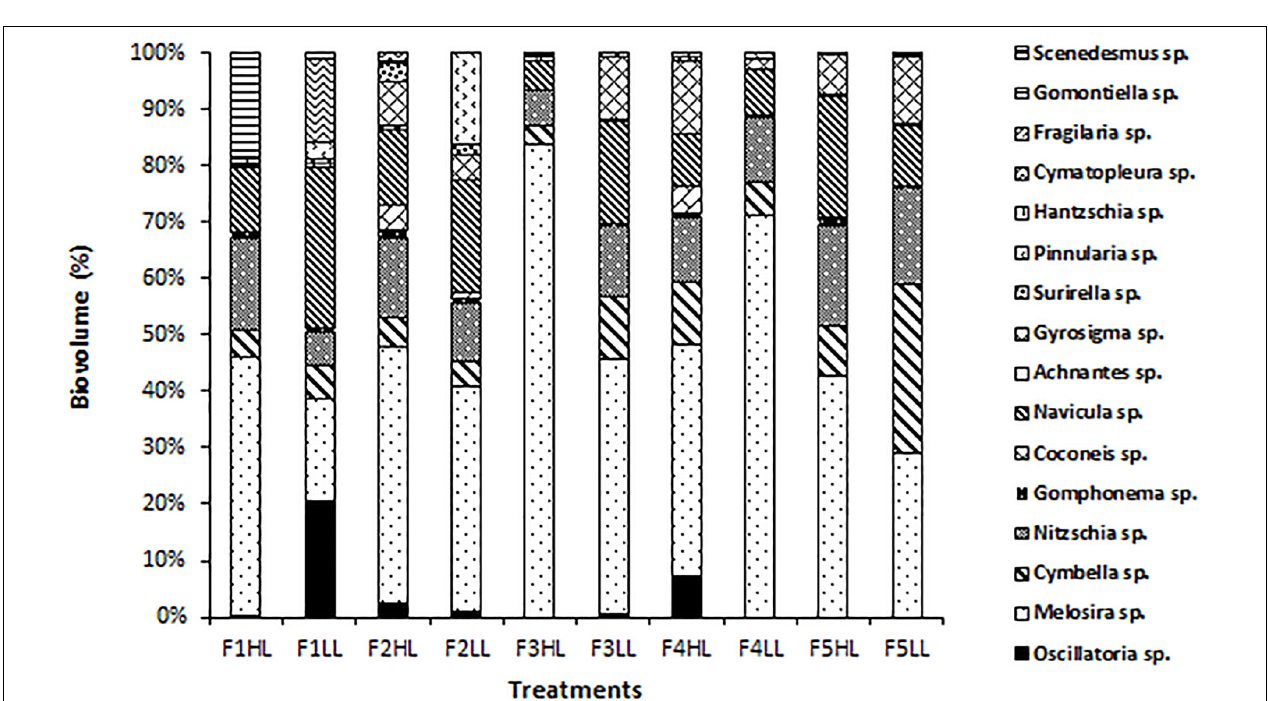
FIGURE 3 | Biovolume (in%) of algae, diatoms and cyanobacteria present in the biofilm of each treatment, from the lowest flow (F1) to the highest (F5), under conditions of natural light (HL) and reduced (LL).